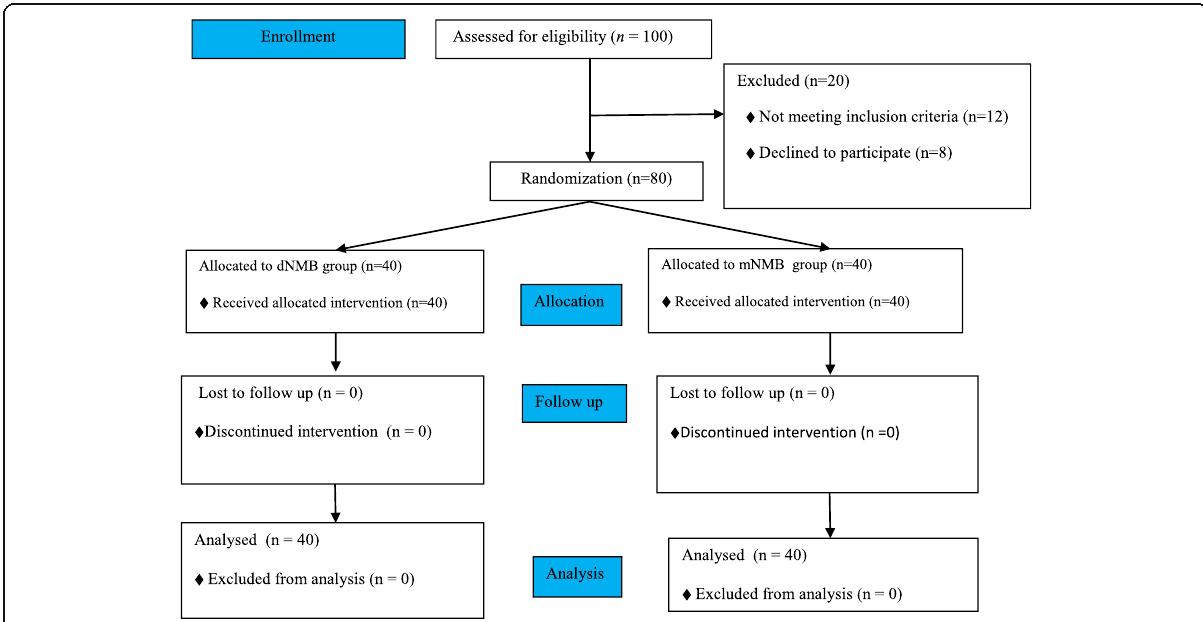
Fig. 1 Consort flow diagram. dNMB, deep neuromuscular block; mNMB, moderate neuromuscular